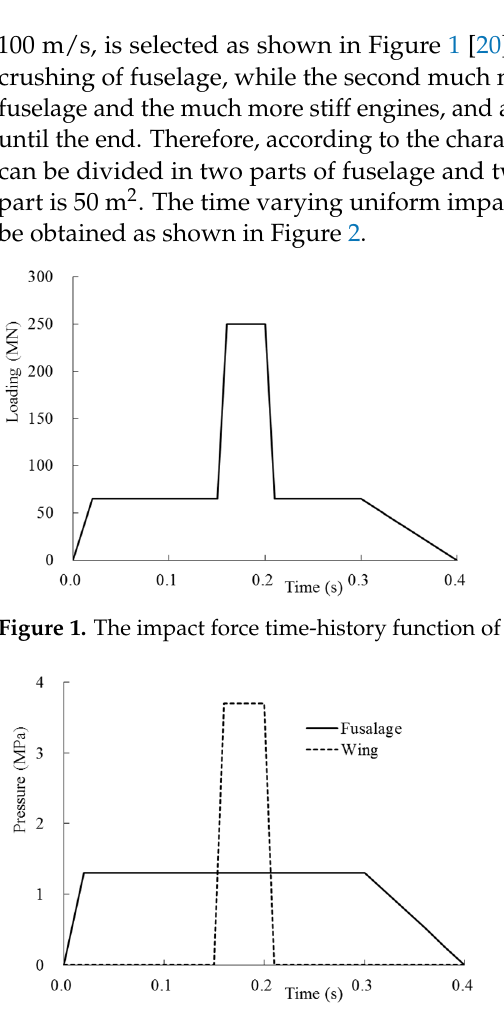
Figure 2. The impact pressure time-history function of fuselage and wing [20].